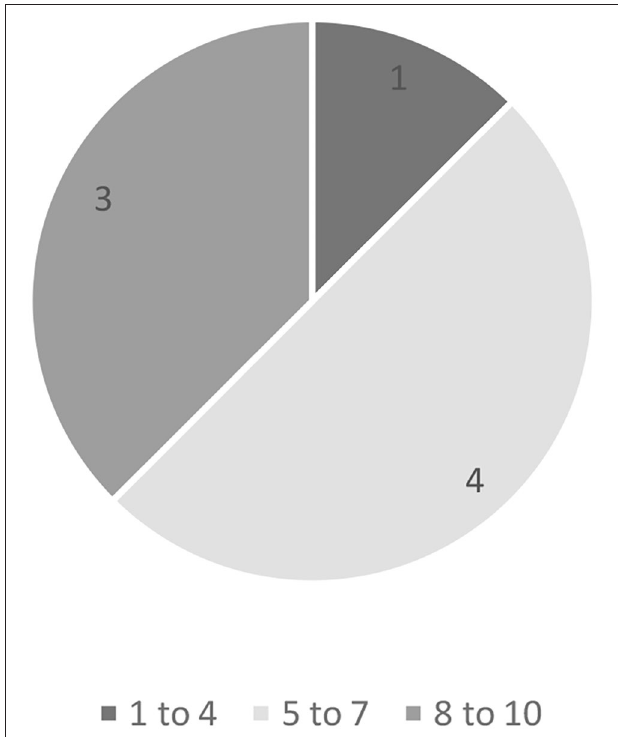
FIGURE 1 | Number of schemes in three score categories (1–4, 5–7, and 8–10, where 10 is the maximum score) illustrating how interested they were in joining the